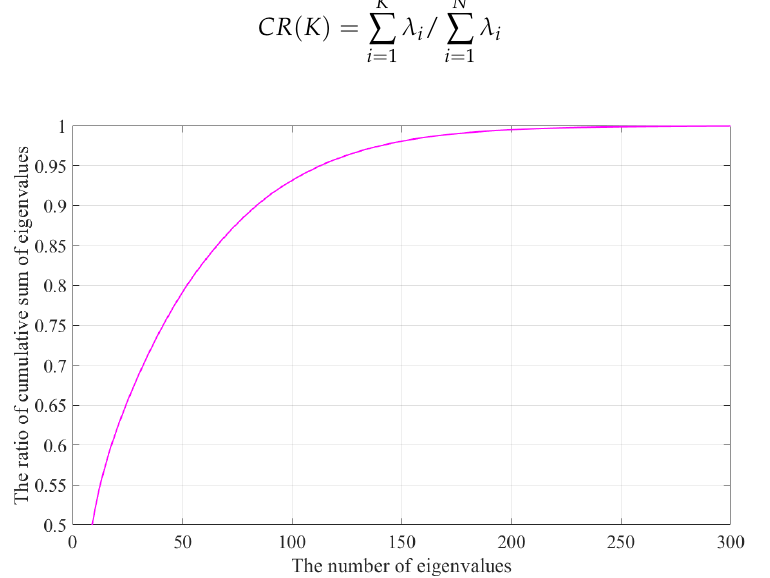
Figure 1. Ratio of cumulative eigenvalues for experimental